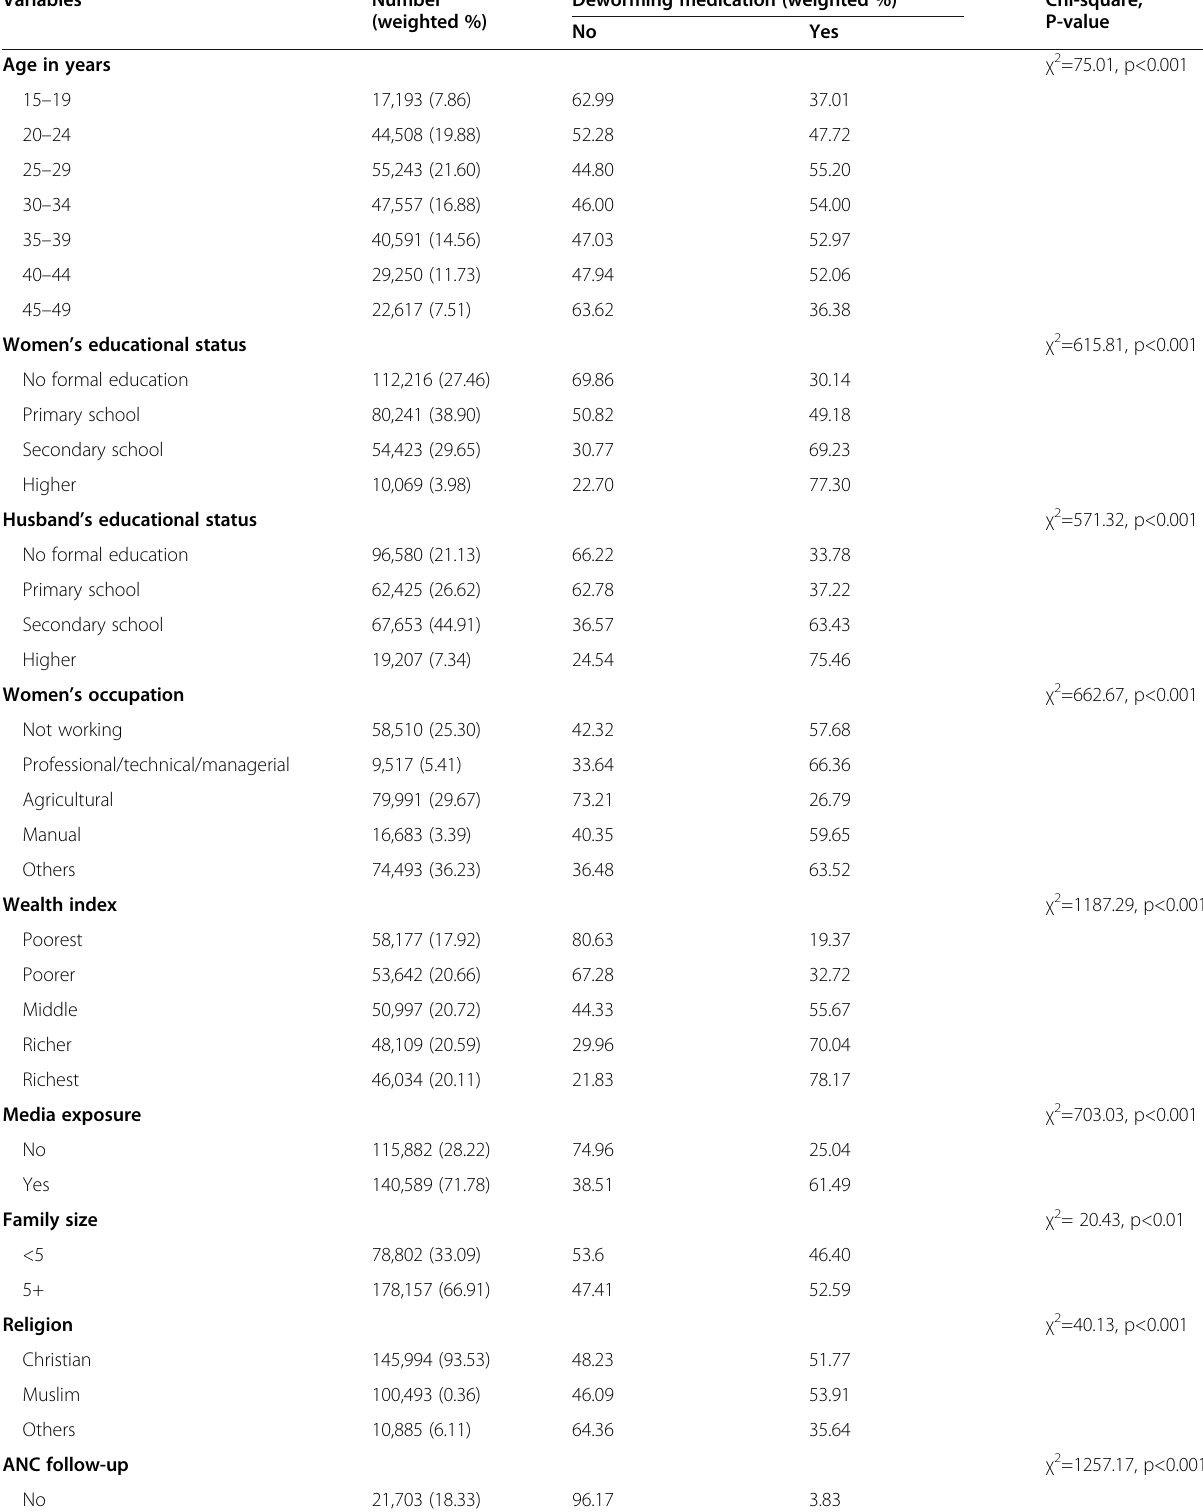
Table 2 Frequency distribution of study participants and deworming distribution across explanatory variables: evidence from 26 sub-Saharan African countries